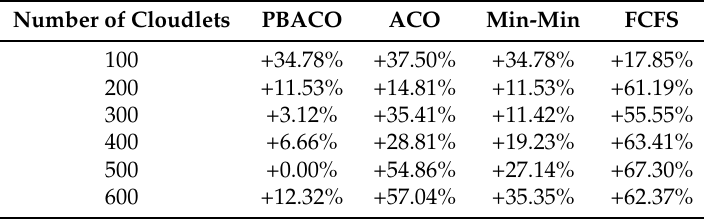
Table 9. Makespan improvements over other